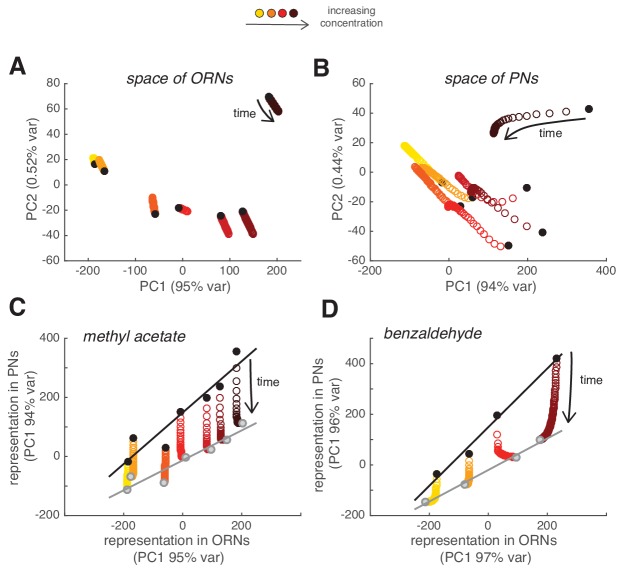
Slow depression linearly rescales odor representations in PN space.(A) Combinatorial representation of methyl acetate represented by the first and second principal components of the ORN activity. Black circles correspond to the response to the first pulse in the random sequence; all other partially overlapping empty circles correspond to the response to subsequent odor pulses, showing how ORN odor representation is stable over 2 min. (B) Same as (A) for the response of PNs, showing how odor representations in PN space change over time. (C) Transformation of spatial representation from ORNs to PNs. Each circle represents the combinatorial response for each single odor pulse of PNs versus ORNs quantified by the first principal component. Black/gray circle: response to first/last odor pulse. Black and gray lines are linear fits to the initial and final response. (D) Same as in (C) but for benzaldehyde.